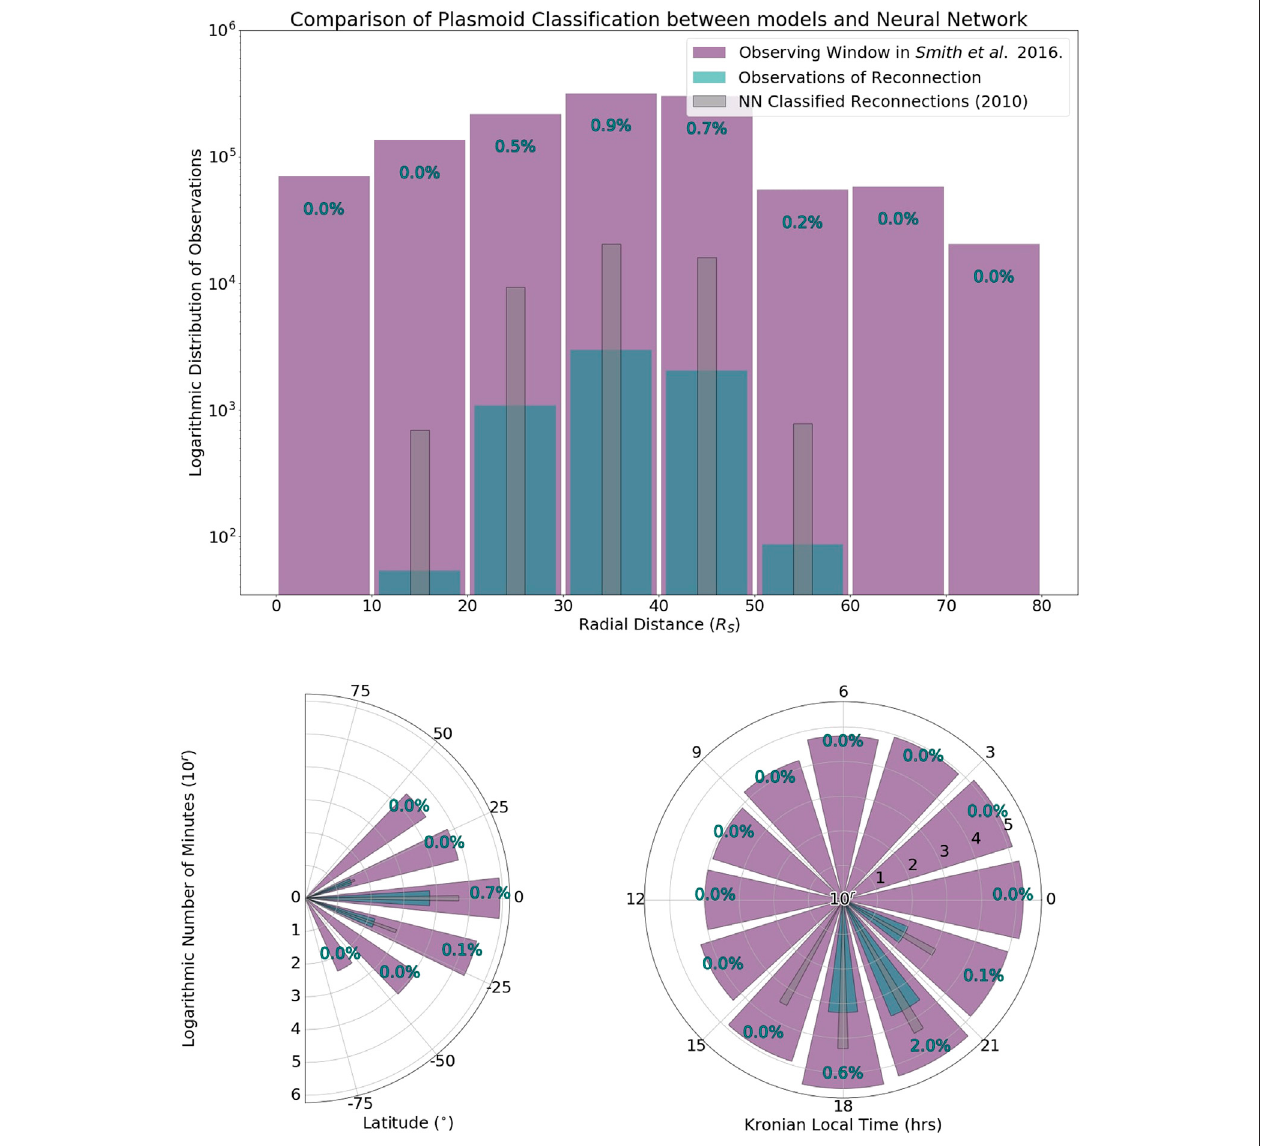
FIGURE 7 | Total time of Cassini observations of Saturn ’ s magnetosphere during the 2010 observing window (purple) with radius, latitude and local time respectively. This distribution is compared to the time classi fi ed as magnetic reconnection signatures by Smith et al. (blue) and as classi fi ed by a neural network method (grey). Percentiles indicate relative time spent near reconnection events as found in the Smith et al. catalog to the total